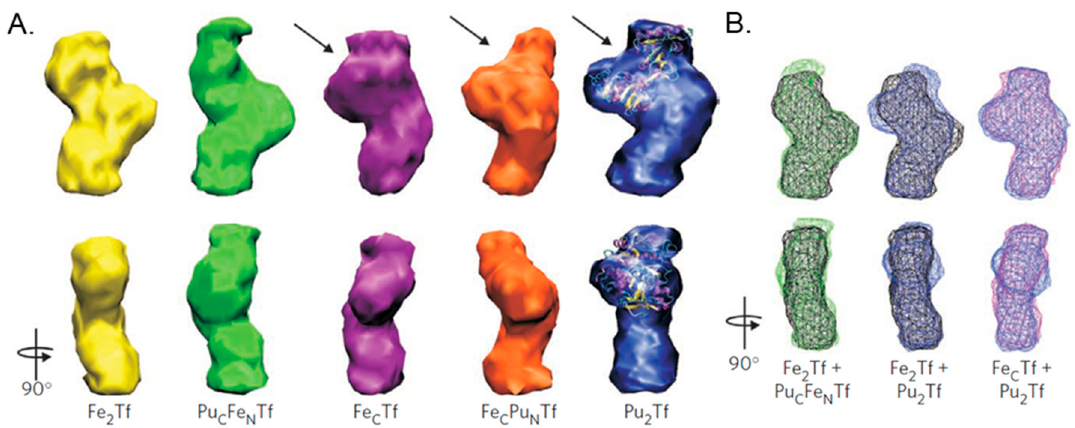
Figure 13. Structural models of Pu(IV) bound, Fe(III) bound, and mixed Pu(IV)/Fe(III) bound bovine sTf derived from small-angle X-ray scattering (SAXS). (A) Three-dimensional structural models derived from SAXS of bovine sTf binding Fe(III), Pu(IV), or a combination of both. The Pu C Fe N Tf adopts a closed conformation. The interdomain cleft in each of the open N-lobes is indicated with arrows, and the open lobe of Pu 2 Tf is superimposed on the crystal structure of open N-terminal recombinant human half apo-transferrin (PDB code: 1BP5). ( B ) Docking wireframe representations of the sTf structures onto each other reveal the closed structures of Fe 2 Tf and Pu C Fe N Tf and the mixed structures Fe c Tf and Pu 2 Tf. Reprinted with permission from [45]. Copyright (2011) Spring Nature Limited. Table 2. The isoelectric points (pI) of apo-sTf and different M-sTf complexes. The pI values were taken from Ref. [59]. (N.D. = Not determined).